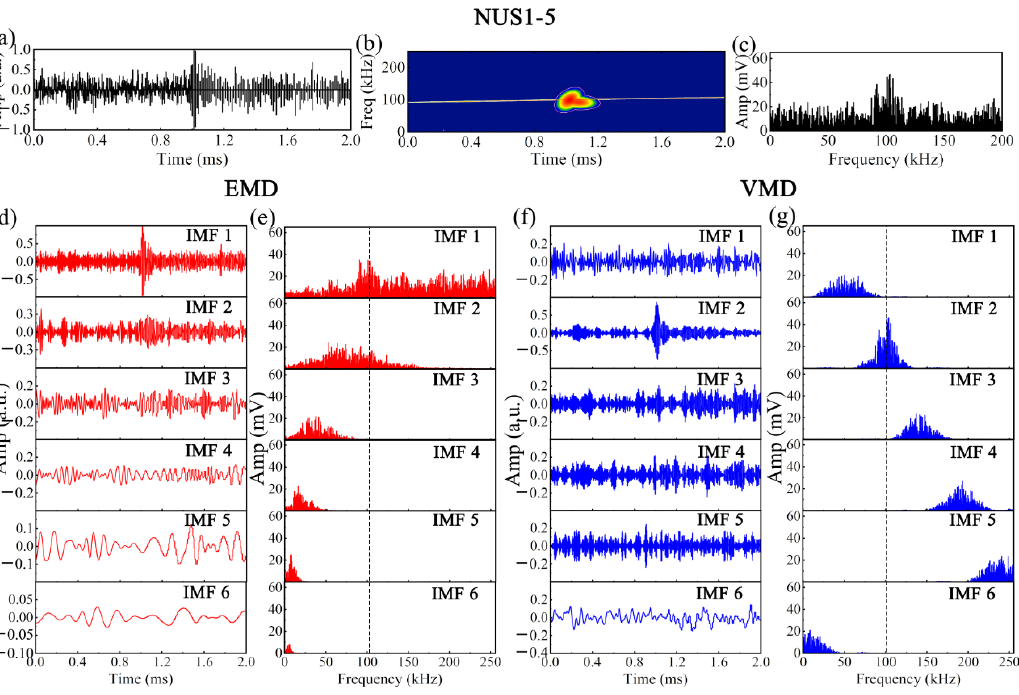
Figure 10. NUS 1 – 5 in the ( a ) time, ( b ) time-frequency, and ( c ) frequency domains; IMFs processed by EMD in the ( d ) time and ( e ) frequency domains; IMFs processed by VMD in the ( f ) time and ( g ) frequency domains.